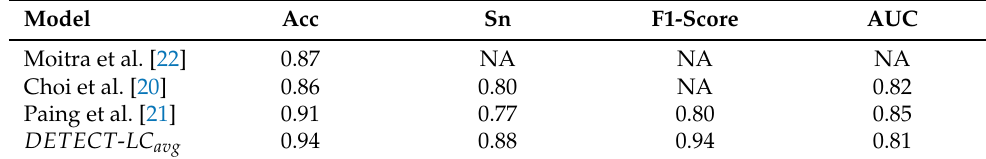
Table 11. State of the Art Staging Results on TCIA NSCLC Datasets.